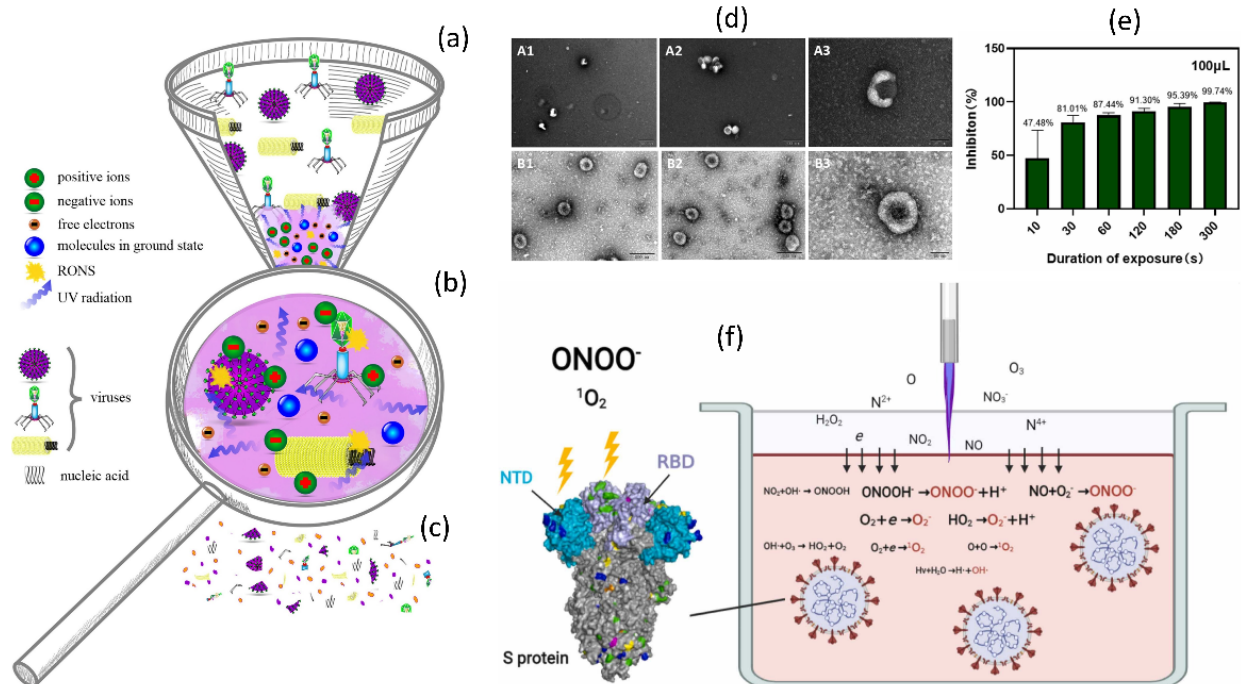
Figure 8. The mechanism of viral inactivation by plasma. ( a ) Morphological differences between viruses exposed to plasma. ( b ) A magnified view of the plasma properties responsible for viral inactivation. ( c ) These virus particles are partially or completely destroyed after being exposed to plasma, resulting in non-infective components. Reprinted with permission from [127]. Copyright 2020, Elsevier. ( d ) TEM images of GX_P2V before and after 3 min of CAP exposure. ( e ) Disinfection of virus with plasma exposure. ( f ) The mechanism through which RONS is produced in Ar-based NTAP damaged S protein. Plasma jet-generated reactive species dissolve into liquid and cross-react in the liquid phase. RONS ONOO − and O 2 − oxidized tyrosine, tryptophan, and histidine are predominate at RBD and NTD, thereby impairing RBD’s capacity to bind to cell receptor ACE2 and NTD’s function. After 3 min of cold atmospheric plasma (CAP) or NTAP treatment, the viral genome remained intact. Reprinted with permission from [146]. Copyright 2022, Elsevier.